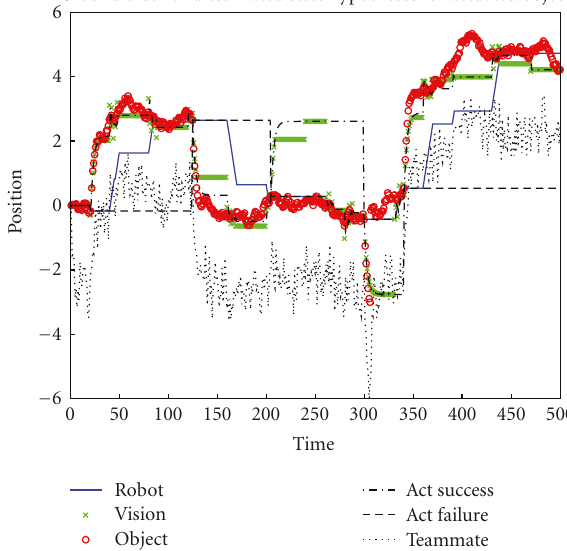
Figure 4: Example run of the one-dimensional simulation showing the robot chasing and actuating an object. After actuating the object, the robot maintains three separate hypotheses: one for actuation success, one for actuation failure, and one for the noisy external teammate observation. Actuation succeeds at times 21, 125, 300, and 341. Actuation fails at time 205. The object is moved by an external force at time 307 and the robot must use the teammate observation to relocalize it. Not shown are the other two objects that the robot is tracking.